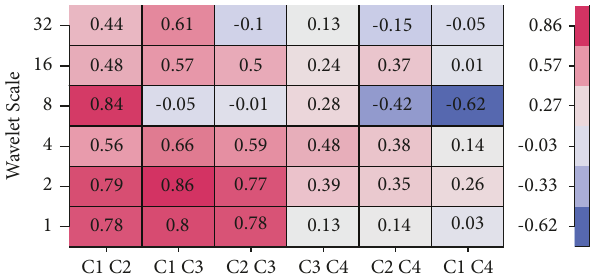
Figure 11: Wavelet bivariate correlations matrix (18/08/2010–03/ 11/2020). The codes for the variables are Czech Republic (C1), Greece (C2), Hungary (C3), and Russia (C4).